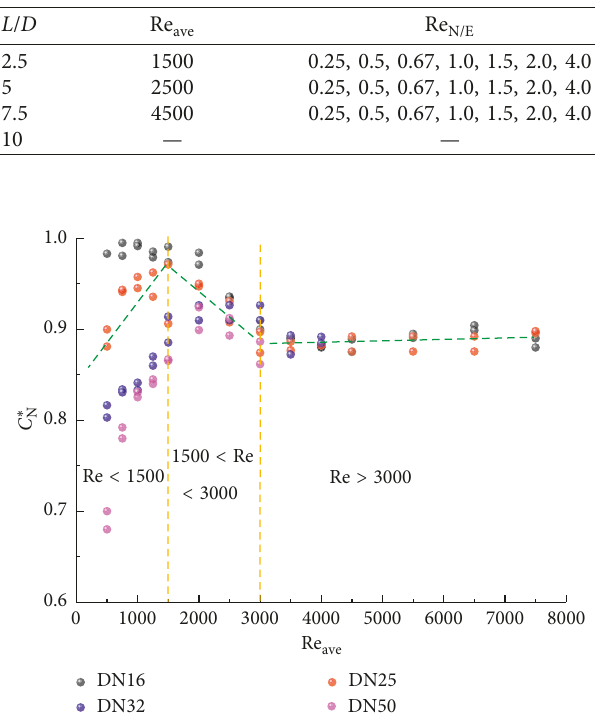
Figure 3: The dimensionless concentration of north outflow C ∗ versus average Reynolds number Re ave .